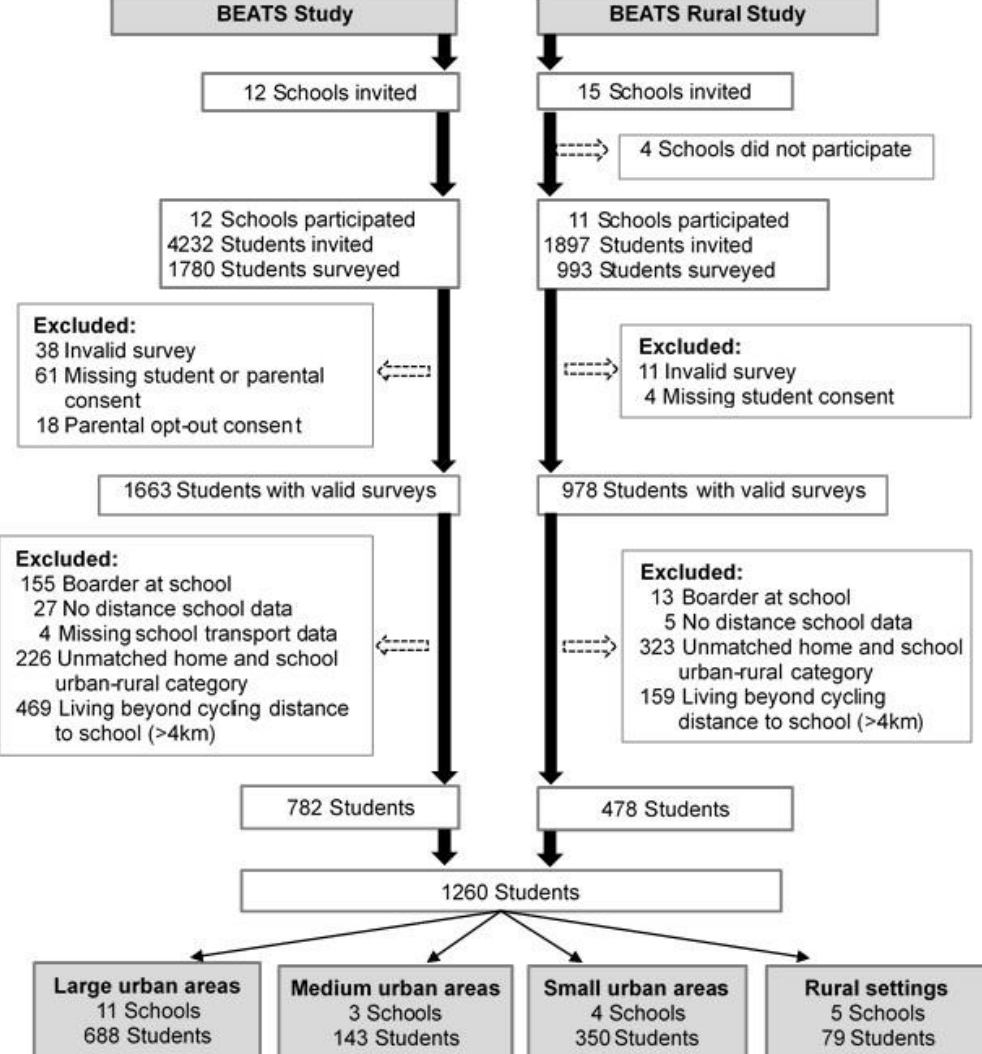
Figure 1. Flow chart of study sample selection. BEATS (Built Environment and Active Transport to School).